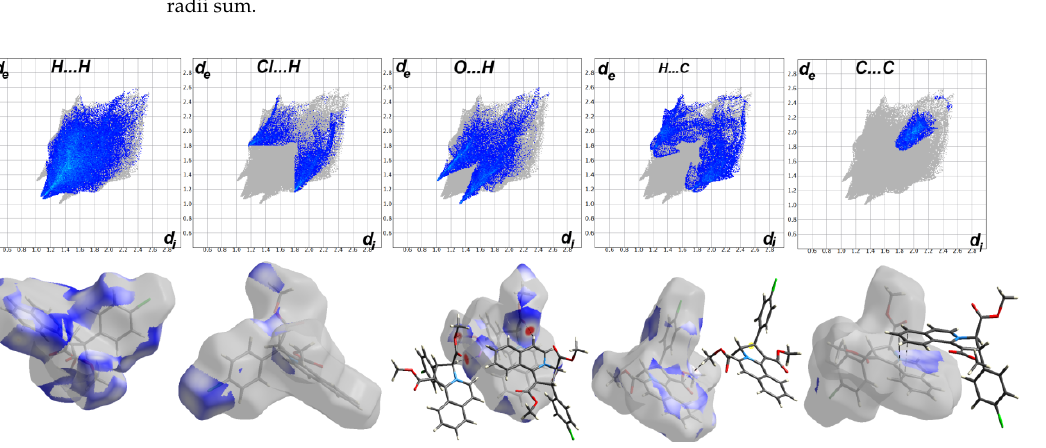
norm surfaces in 3